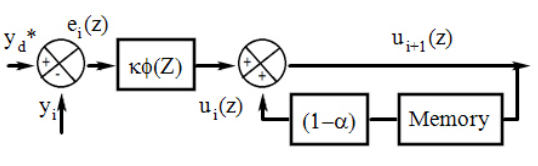
Figure 8. ILC with forgetting factor.